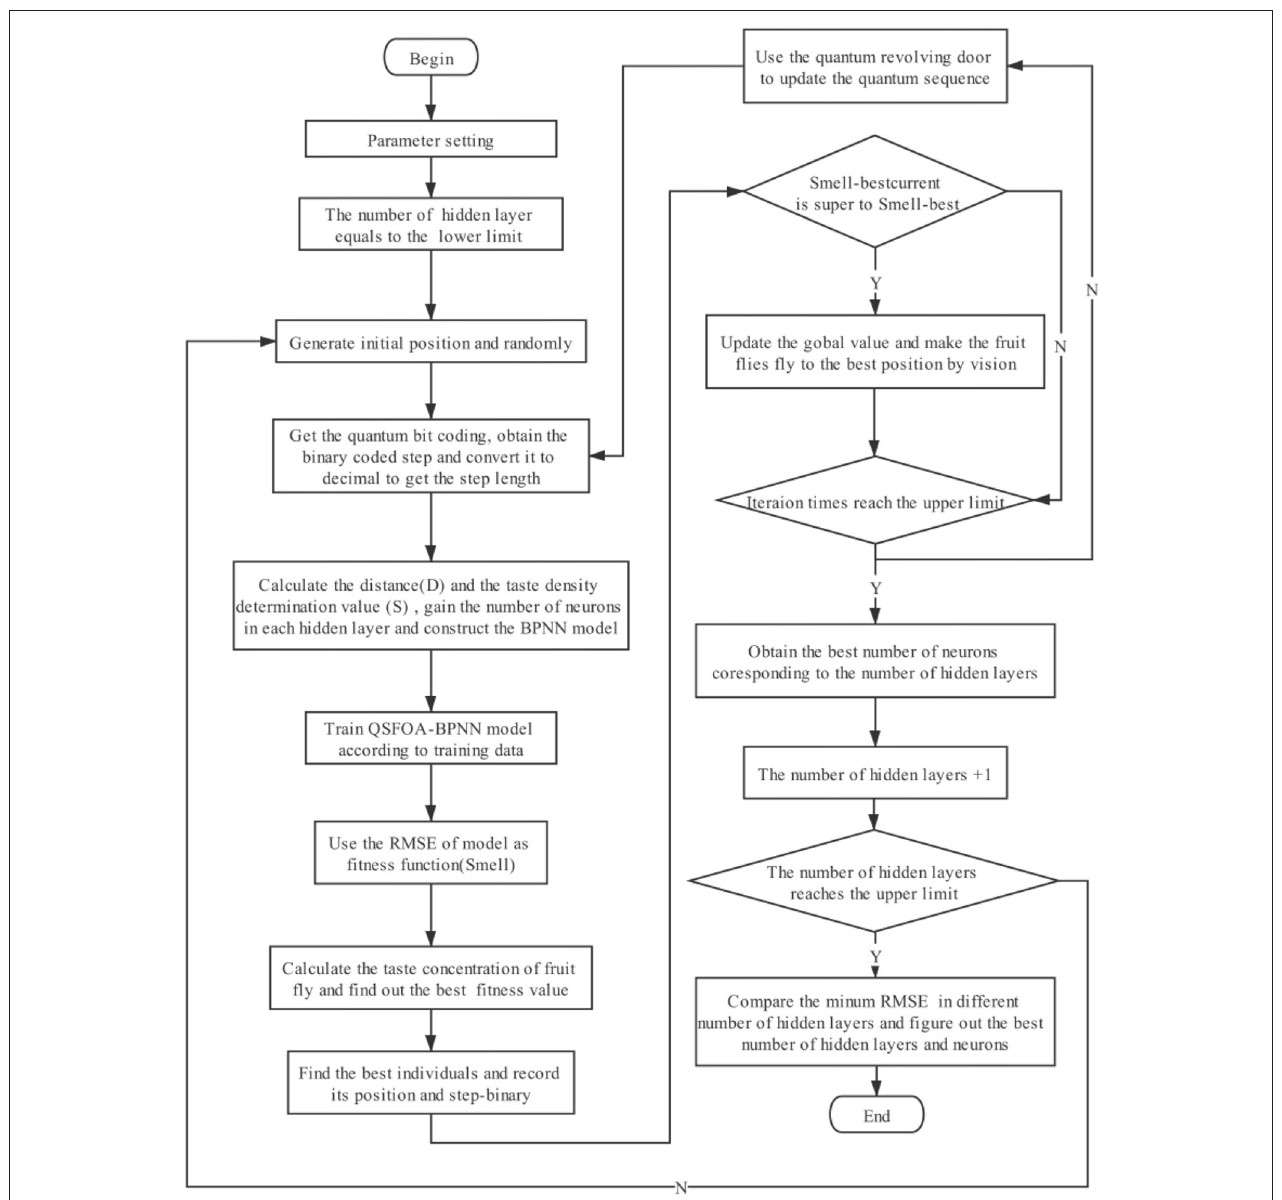
FIGURE 3 | Specific algorithm flow chart of QSFOA-BPNN.